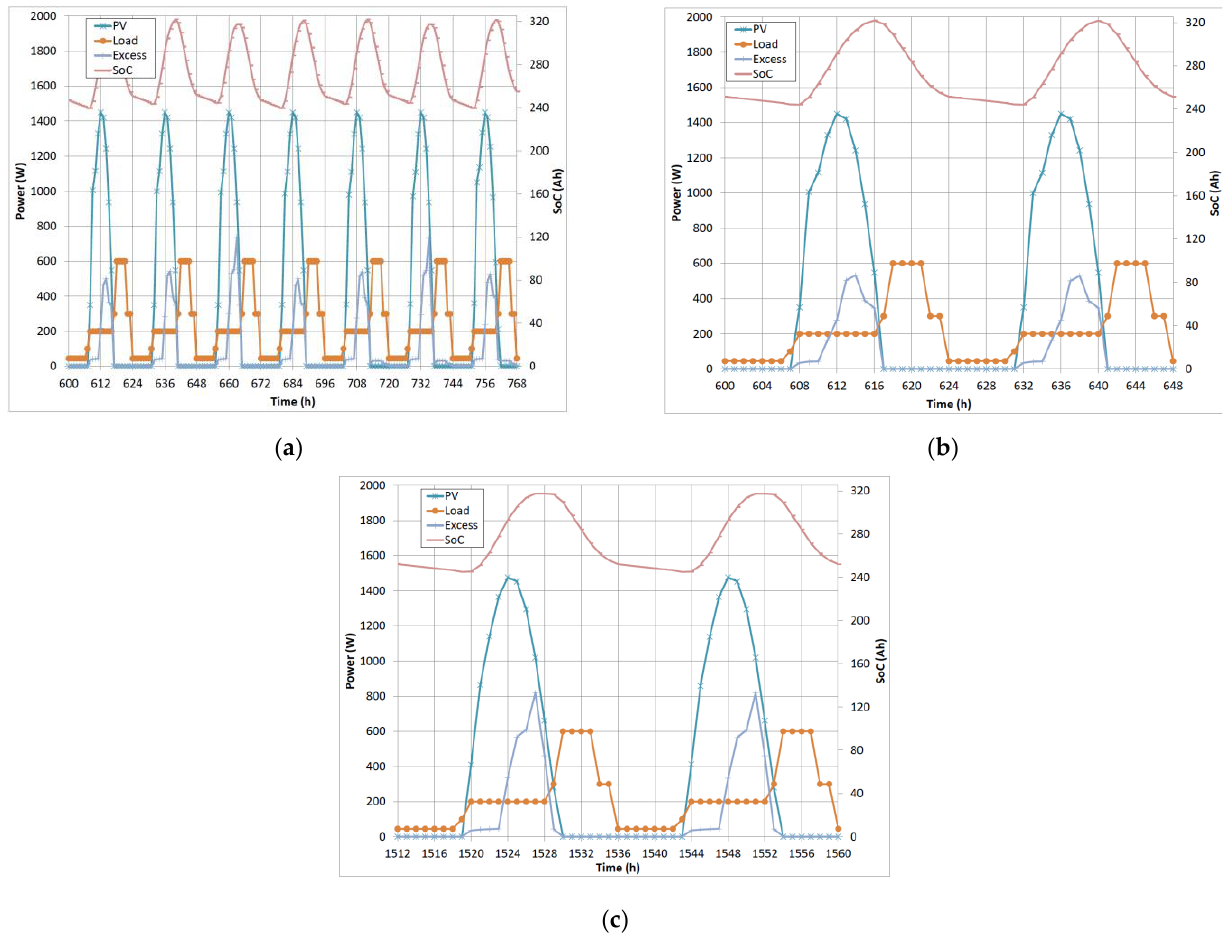
Figure 5. Typical analysis results in January for: ( a ) a week and ( b ) two days; and in March ( c ).